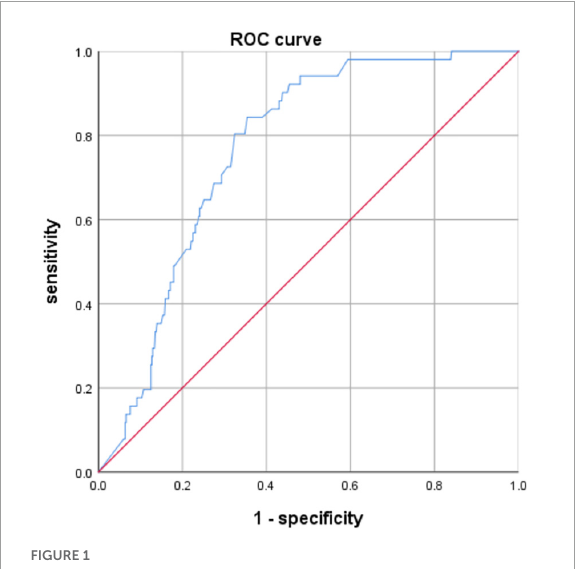
FIGURE1 ROC curve of the A/H ratio.